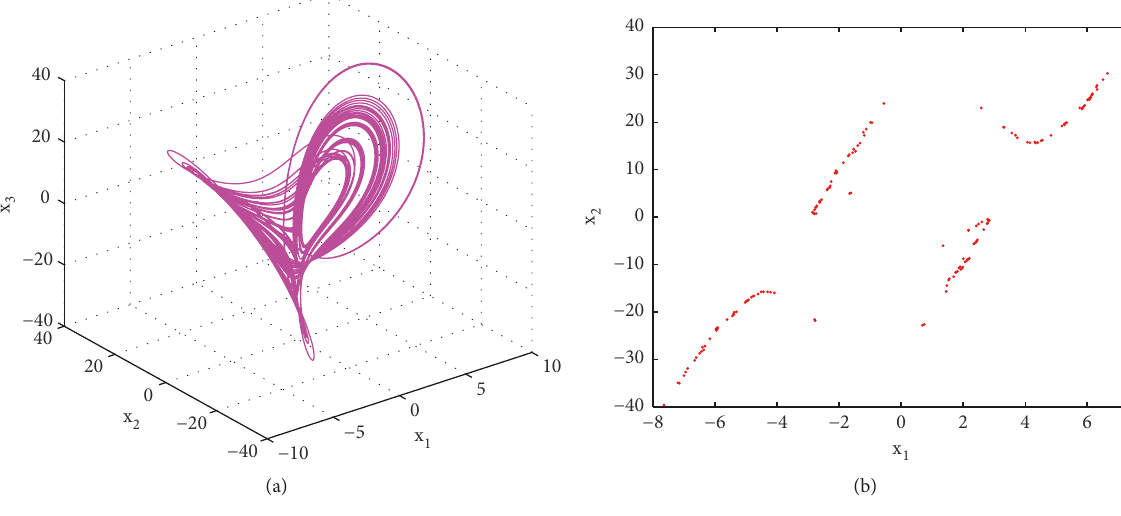
Figure 1: (a) 3D phase portrait; (b) Poincar´e map with x 3